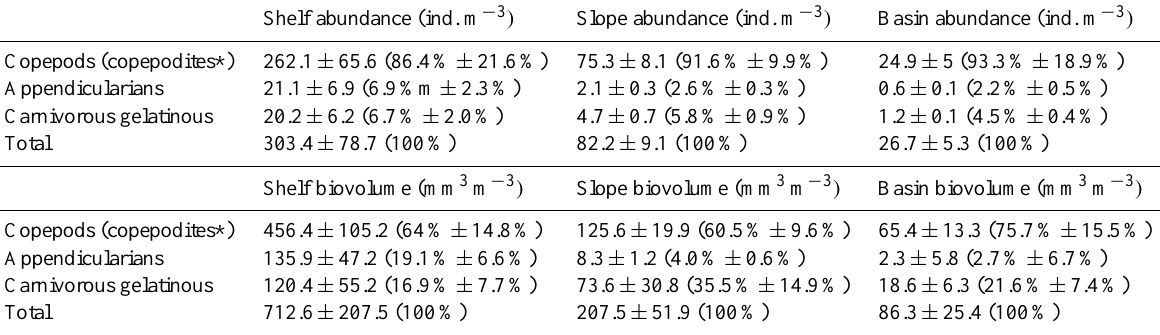
Table 4. Abundance and biovolume of copepods (copepodites, including adults) and appendicularians (mean ± SE and percent contribution in brackets) as estimated with ZooScan analyses on the samples from integrated vertical net tows (bottom to surface, 200µm mesh size) conducted in the shelf ( < 100m), slope (100–1000m) and basin ( > 1000m) regions of southeast Beaufort Sea in July–August 2009 (Fig. 1). The data presented in this table summarize the whole ZooScan dataset comprising 28 samples (Appendix